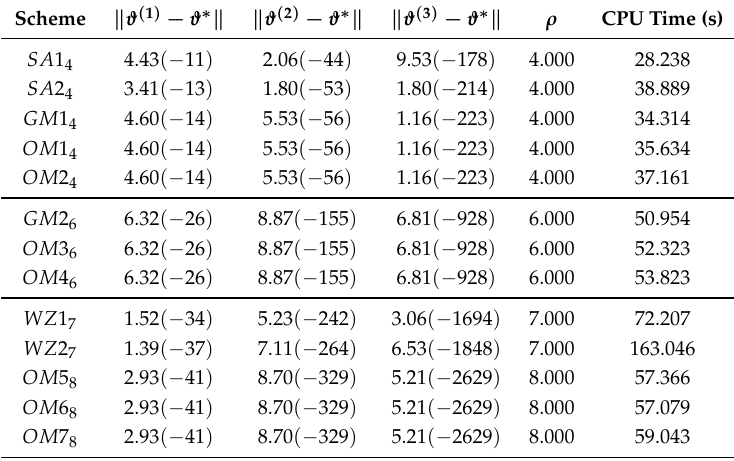
Table 4. Comparison of distinct iterative schemes on Example